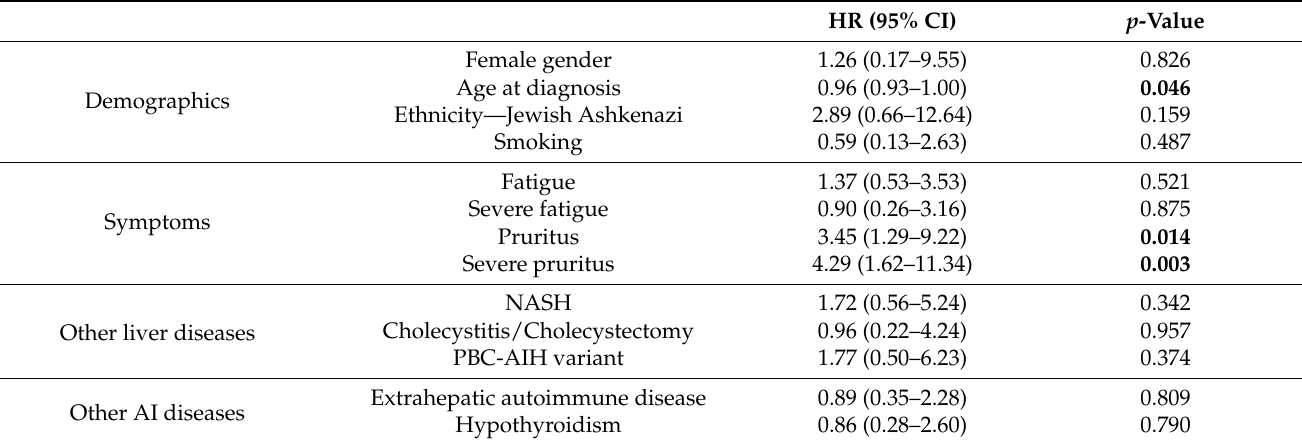
Table 4. Univariable analysis for reaching a clinical